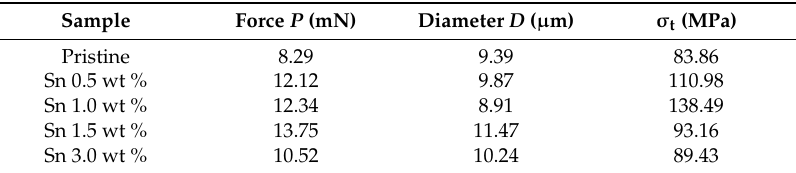
Figure 4. XPS of the cathode active materials. Table 2. Breaking strength of the cathode active material particles.